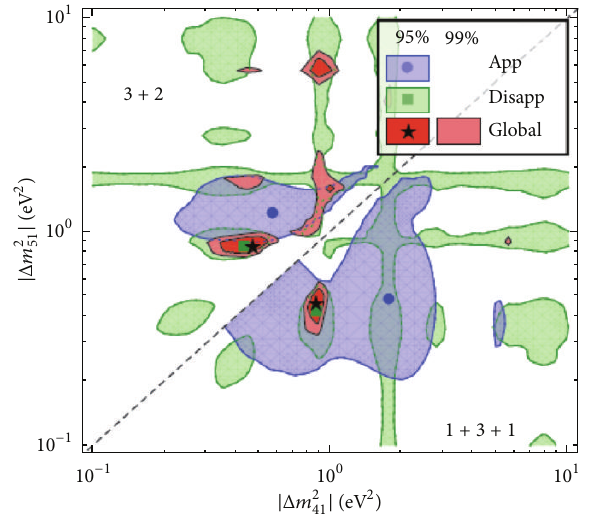
Figure 17: The 3 + 2 and 1 + 3 + 1 best fit Δ𝑚 2 41 versus Δ𝑚 2 51 values from